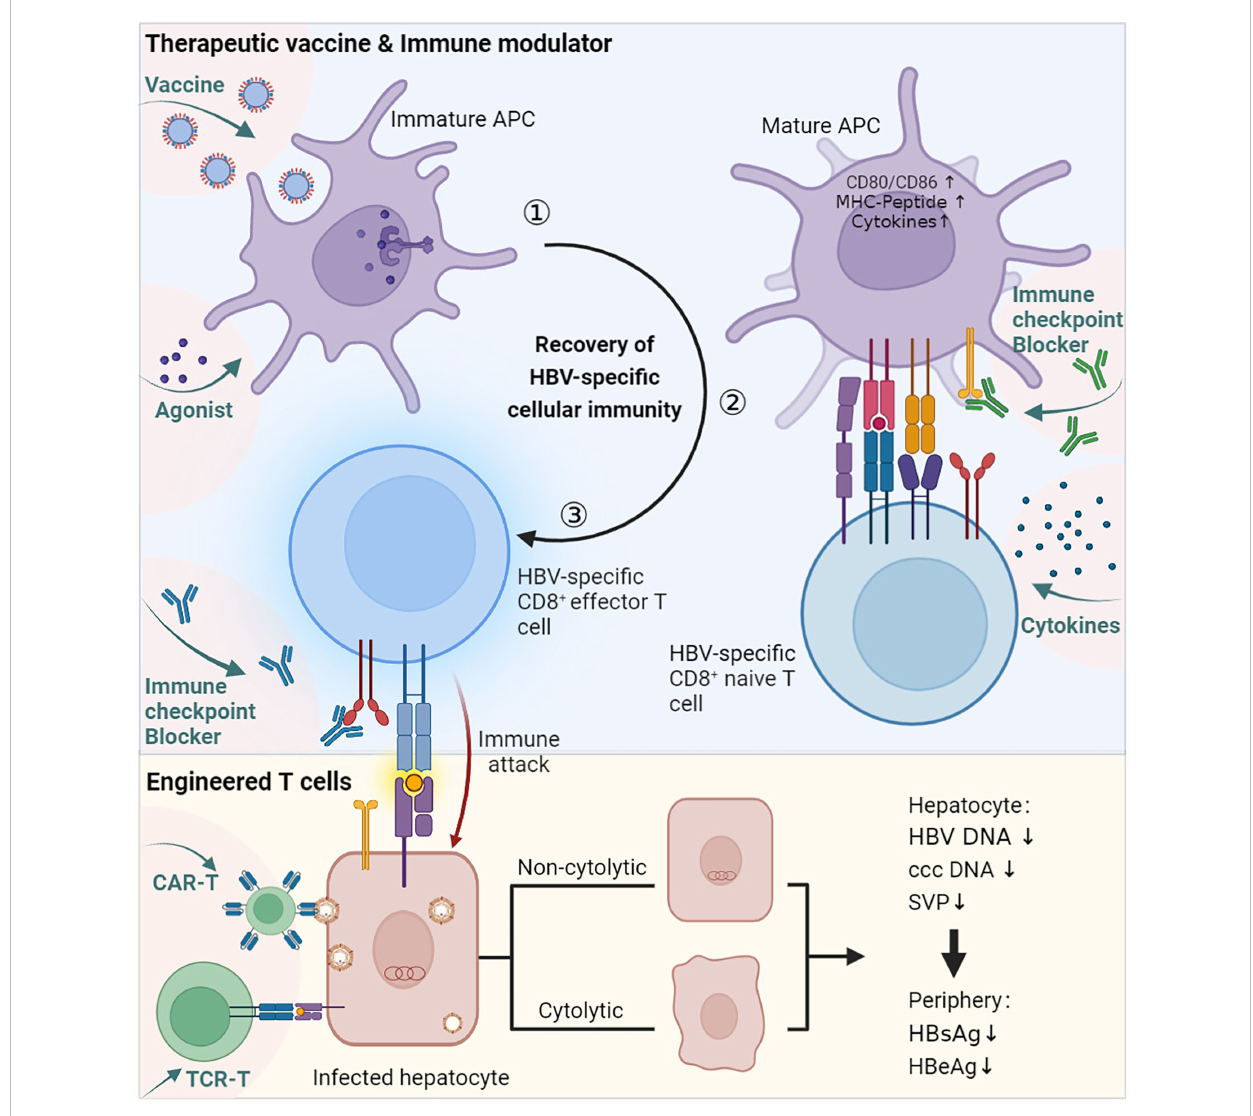
FIGURE 3 Immune therapies promote the recovery of HBV-speci fi c cellular immunity. ① Vaccine and agonist stimulation. Therapeutic vaccines are generally designed to be taken up by professional APCs and enhance the immunogenicity of virus-associated antigens. The agonist works by promoting the activation of APCs. ② Activated APCs mature and interact with HBV-speci fi c CD8 naïve T cells. During this process, other immune modulators, such as active cytokines, can help activate T cells, and immune checkpoint blockers can prevent inhibitory signalling. ③ Naïve CD8 T cells are stimulated and differentiate into effector cells. Engineered T cells can bypass APC priming and act directly on infected hepatocytes. The immune therapies described above concentrate on the priming progress of HBV-speci fi c CD8 T cells, which mediates cytolytic or noncytolytic immune attacks on infected hepatocytes, ultimately resulting in a decrease in HBV-related viremia. This fi gure was created with BioRender.com